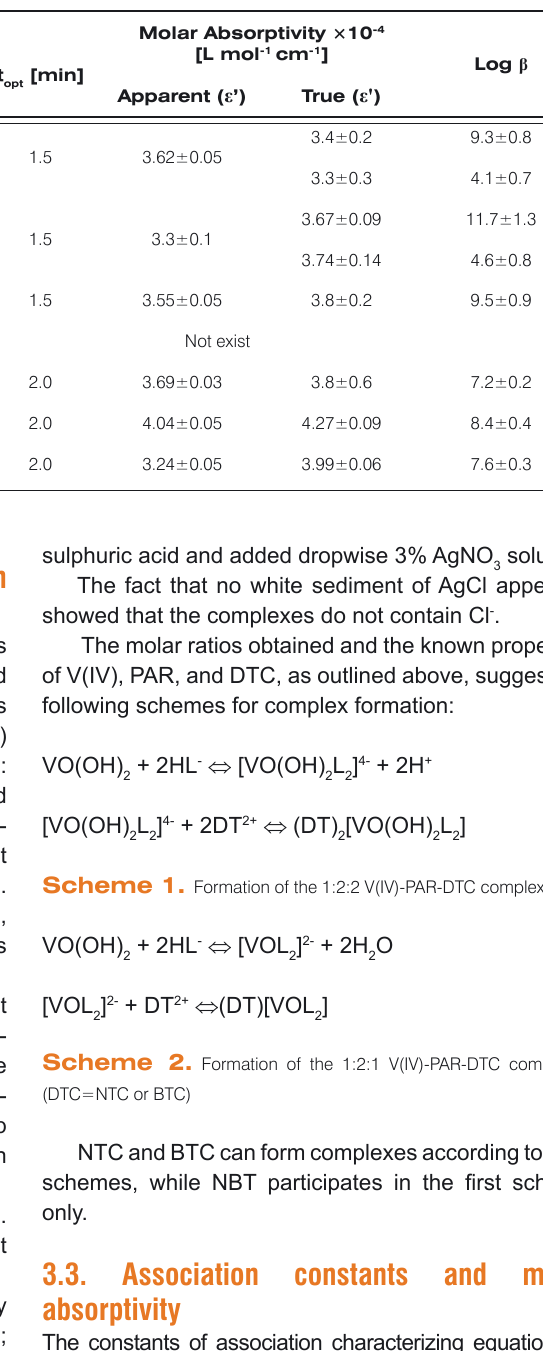
) for ternary complexes of V(IV) and opt